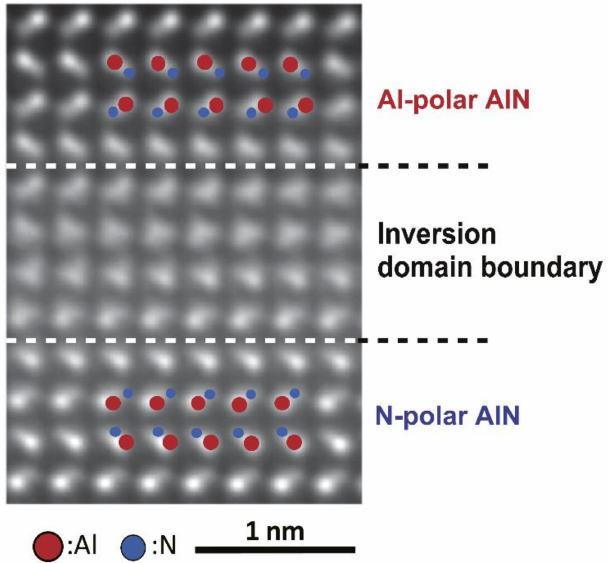
Figure 17. Cross-sectional TEM microscopy image along [11–22] direction of AlN films after HTA process, showing the polarity inversion region. Reprinted from [80]. Copyright (2019) The Japan Society of Applied